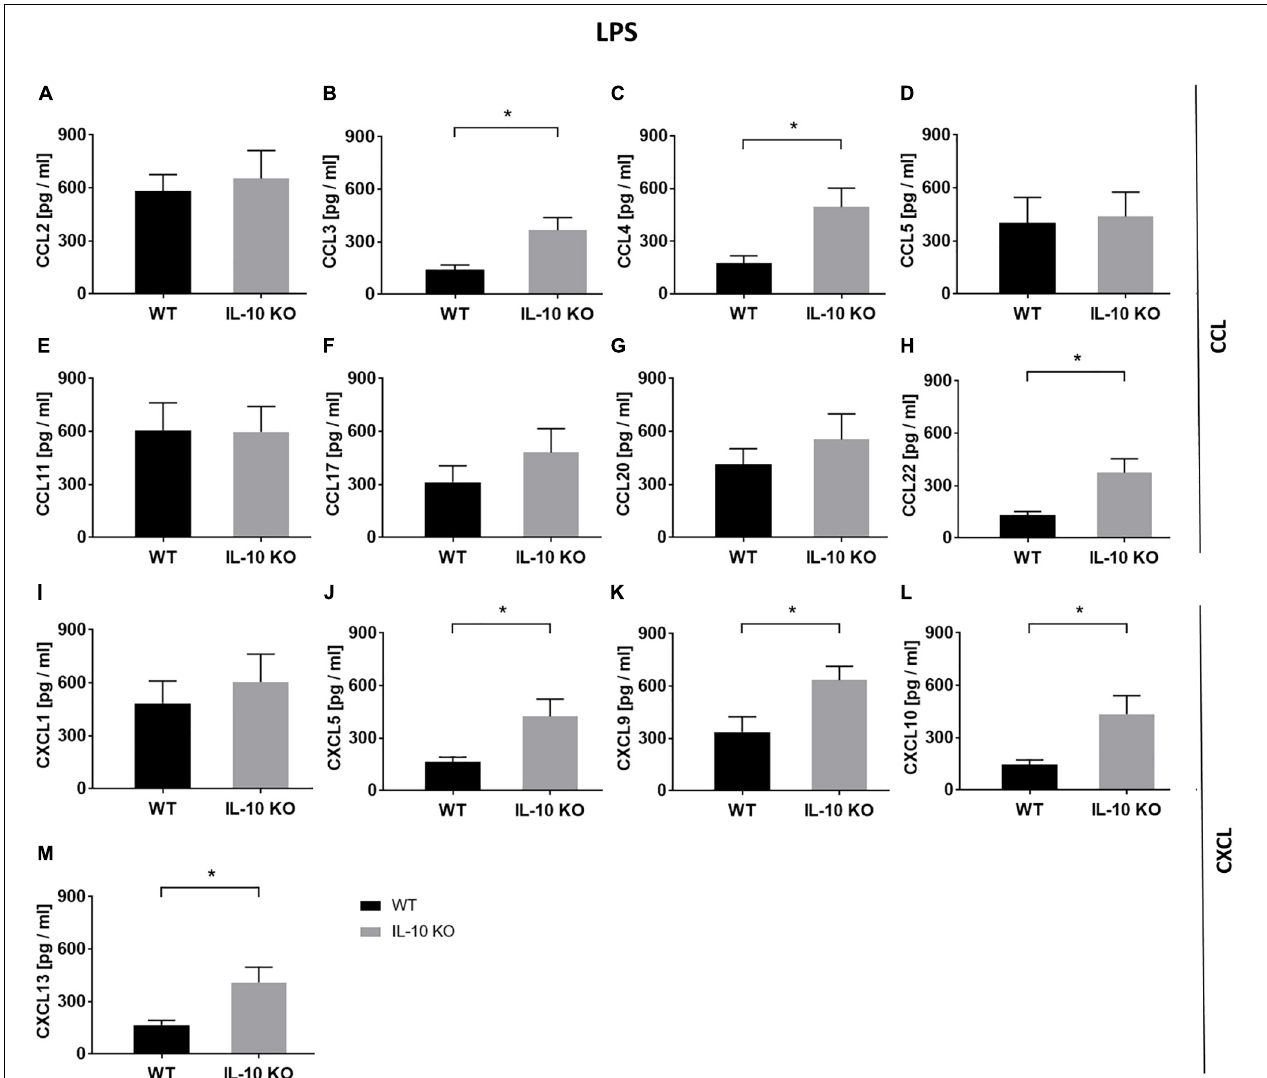
FIGURE 3 | Chemokine release ( (cid:49) : LPS minus control) of WT (black bars) and IL-10 KO (gray bars) microglia under LPS treatment. LEGENDplex TM data in pg/ml, (A) CCL2, (B) CCL3, (C) CCL4, (D) CCL5, (E) CCL11, (F) CCL17, (G) CCL20, (H) CCL22, (I) CXCL1, (J) CXCL5, (K) CXCL9, (L) CXCL10, and (M) CXCL13 ( N = 8), mean ± SEM. Unpaired t -test, ∗ p <